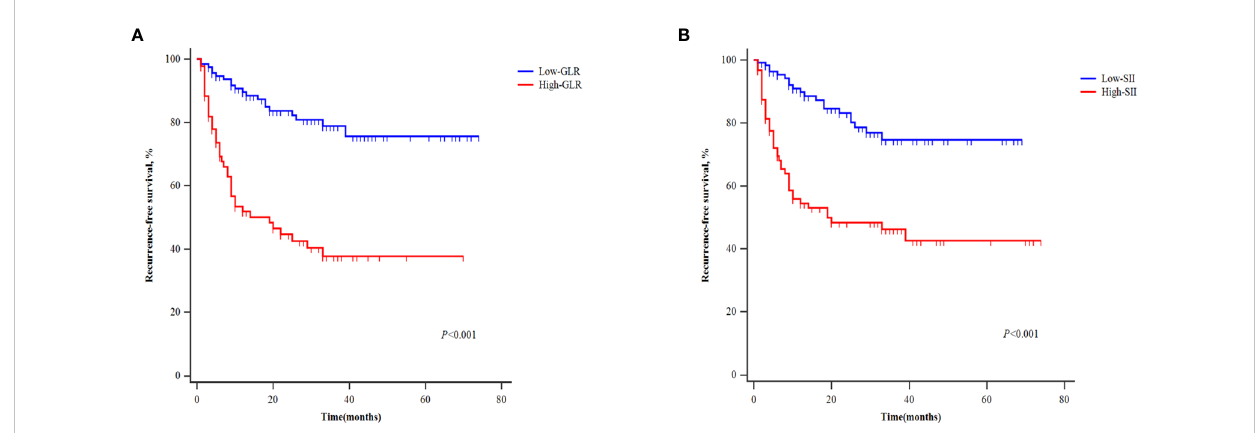
FIGURE 3 Kaplan ‐ Meier curves of patients with different levels of GLR (A) and SII (B) for recurrence-free survival.